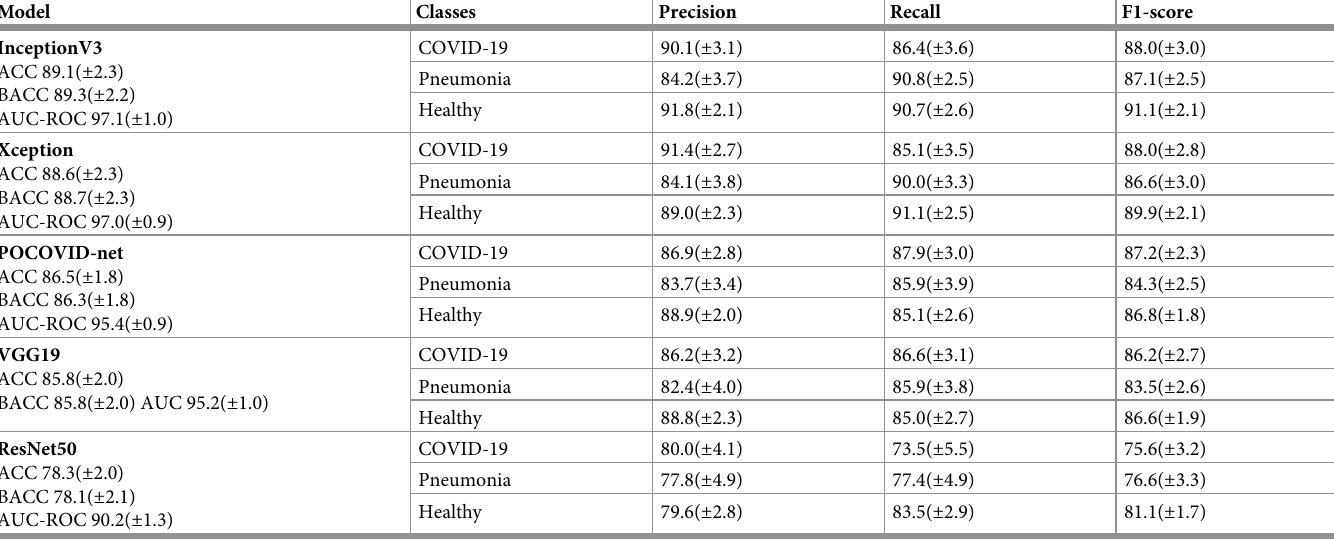
Table 2. Overall performance results of the evaluated models (95% C.I.). Model Classes Precision Recall